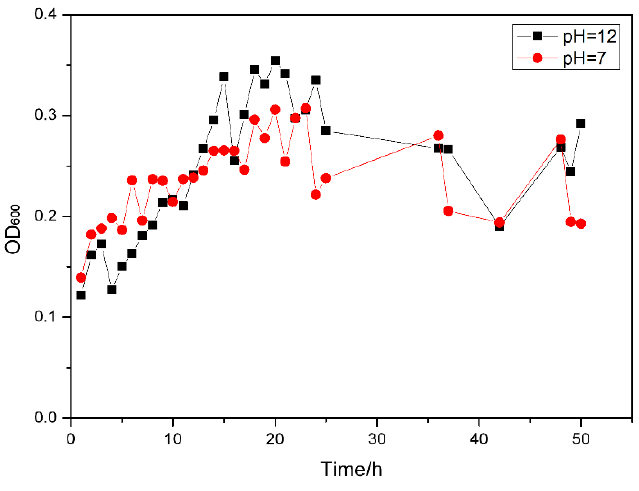
Figure 2. Biomass of strains using PET as a carbon source.